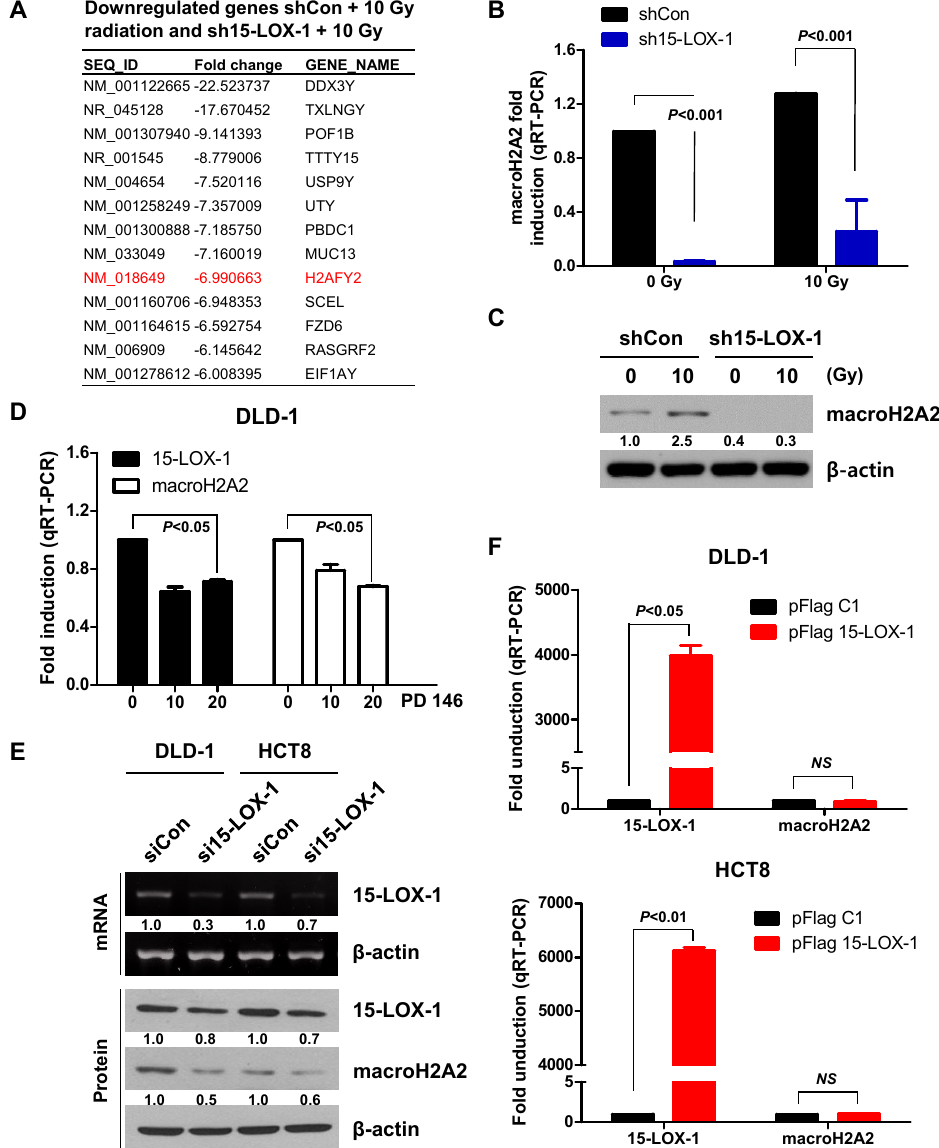
Figure 4. MacroH2A2 is transcriptionally regulated by 15-LOX-1 in colon cancer cells. ( A ) Genes downregulated by > sixfold between two groups. ( B , C ) MacroH2A2 levels of stable cell lines were measured by qRT-PCR and Western blotting 24 h after irradiation, to validate the microarray results. ( D ) MacroH2A2 expression in DLD-1 cells 24 h after PD146176 treatment. ( E ) MacroH2A2 expression in the transfected cells; mRNA levels of 15-LOX-1 were evaluated to confirm transfection e ffi ciency. ( F ) MacroH2A2 mRNA levels were analyzed by qRT-PCR 24 h after transfection with a 15-LOX-1